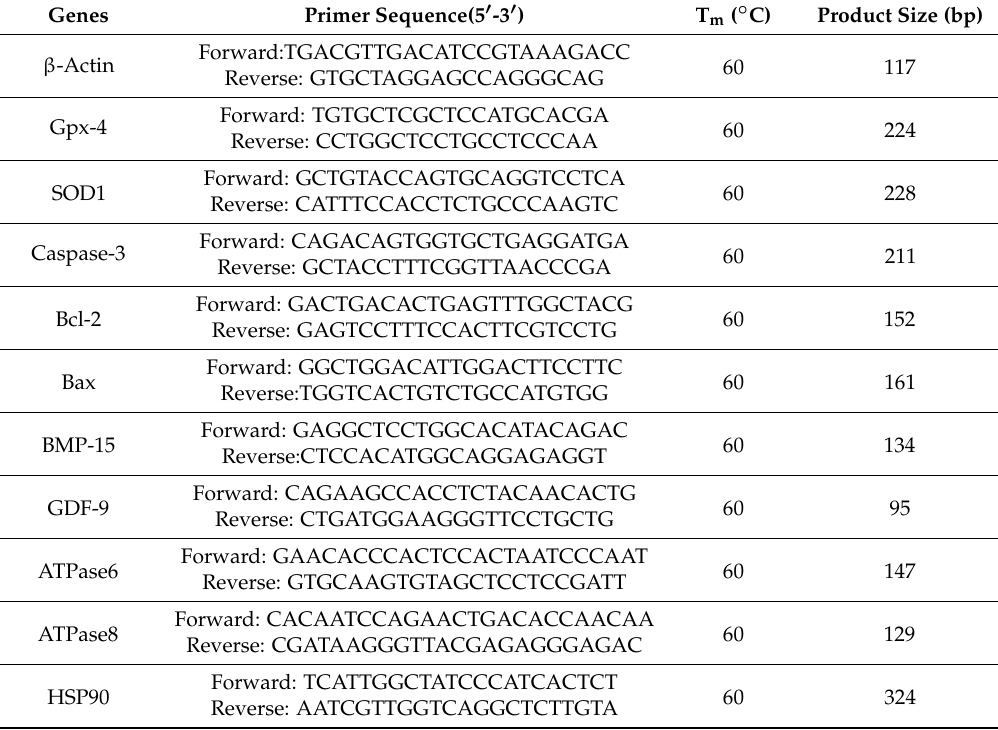
Table 4. Primers used in this